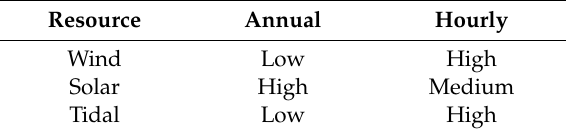
Table 1. Variability of different renewable energy sources; adapted from [62]. Table 1 . Variability of different renewable energy sources; adapted from [62].